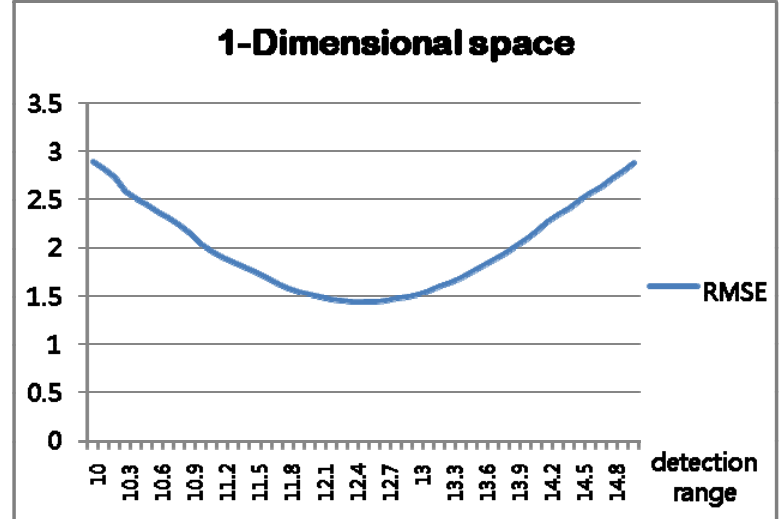
Figure 16. RMSE according to detection range in 1-dimensional